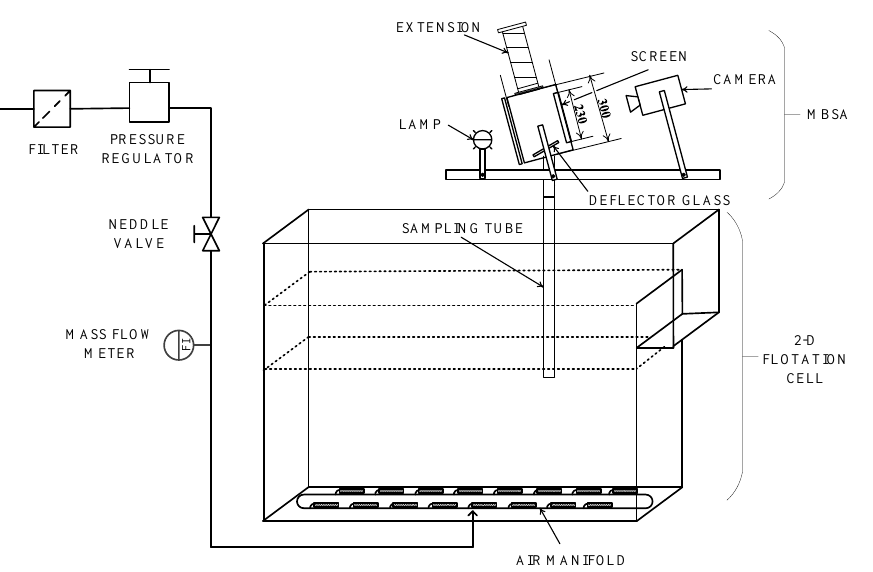
Figure 1. Two-dimensional flotation cell and installation of the McGill bubble size analyzer (modified from [32] ).